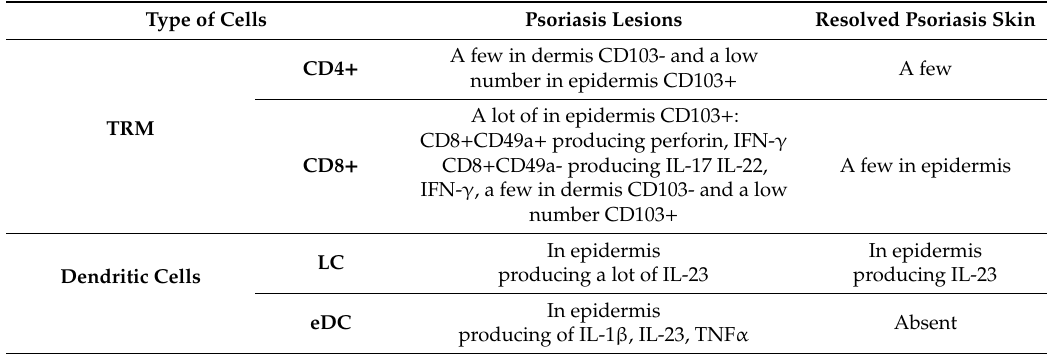
Figure 1. The relapse of psoriatic lesions in the same localization despite efficient treatment. Table 1. The Cells Responsible for the “memory” of Psoriatic Lesions.